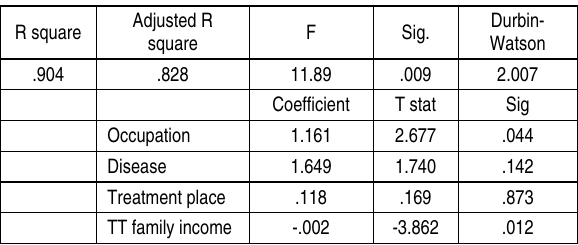
Table 3. Regression equation 3, dependent